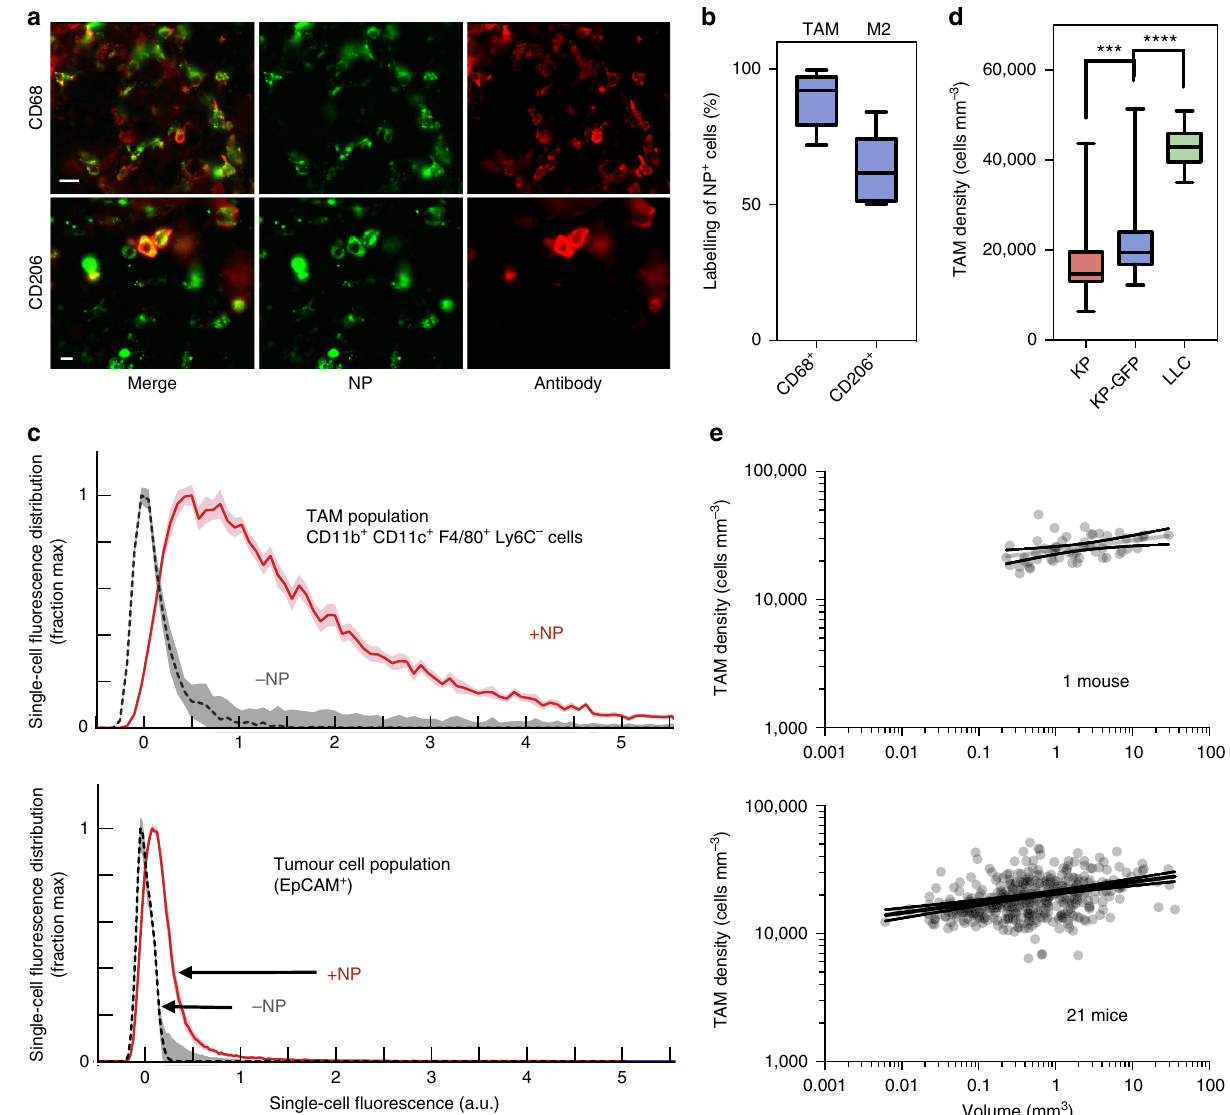
Figure 3 | Identification and quantification of TAM infiltration. ( a ) IHC on formalin-fixed KP tumour sections, staining for CD68 and CD206 macrophage markers. Scale bar, 10 m m. ( b ) Analysis of NP þ cells by IHC for CD68 and CD206 ( n ¼ 3 images). ( c ) NP was found in TAM (CD11b þ CD11c þ F4/80 þ Ly6C (cid:3) ), whereas the NP did not accumulate in tumour cells (RFP). ( d ) Average TAM density in KP, KP-GFP and LLC tumour models as calculated from imaging (KP, n ¼ 158; KP-GFP, n ¼ 38; LLC, n ¼ 6; *** P ¼ 0.0003; **** P o .0001; one-way ANOVA). ( e ) Tumours plotted by size and TAM infiltrate for one mouse (top) and in relation to 20 other mice (bottom) to show range of tumour size and TAM infiltration. Scale bars, 10 m m. ANOVA, analysis of